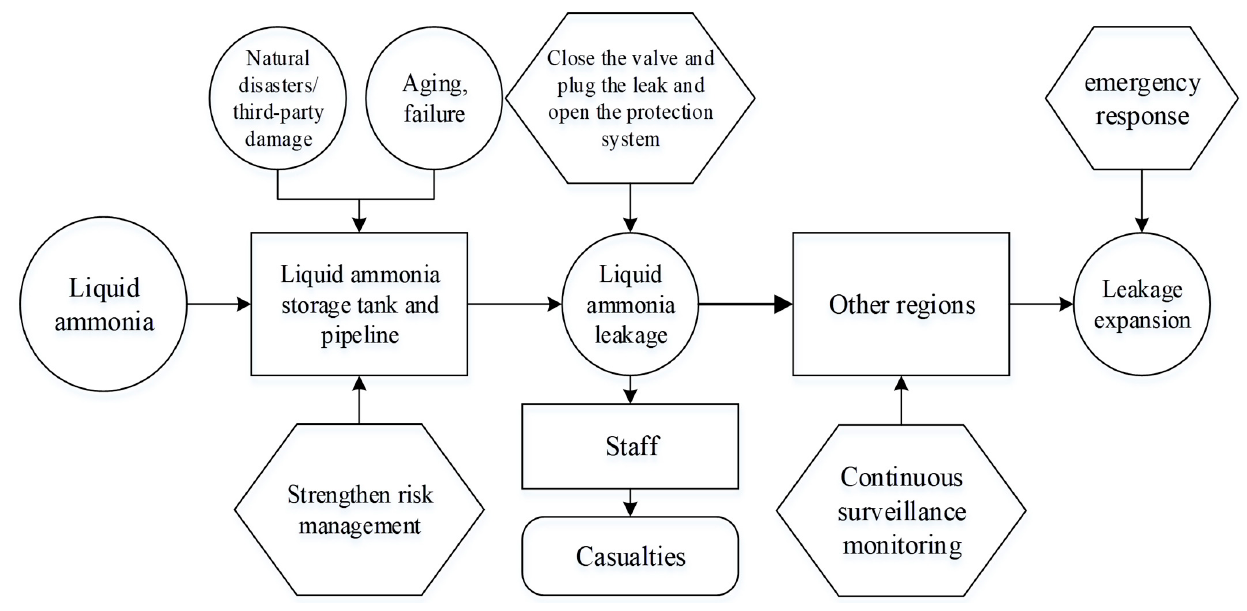
Figure 1. The evolution process of liquid ammonia leakage scenario in the refrigeration plant.